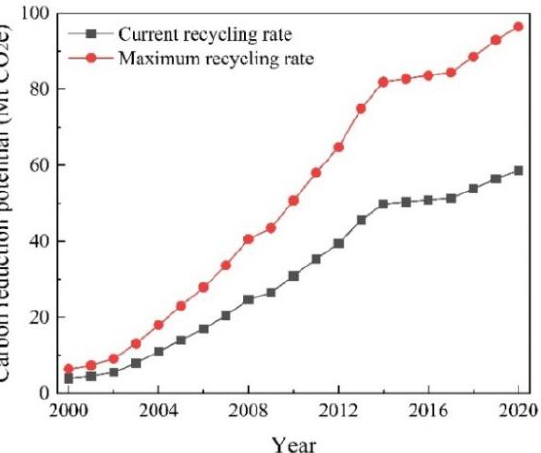
Figure 8. The annual carbon reduction potential of recycling CDRW at different recycling rates in Jiangsu Province from 2000 to 2020.